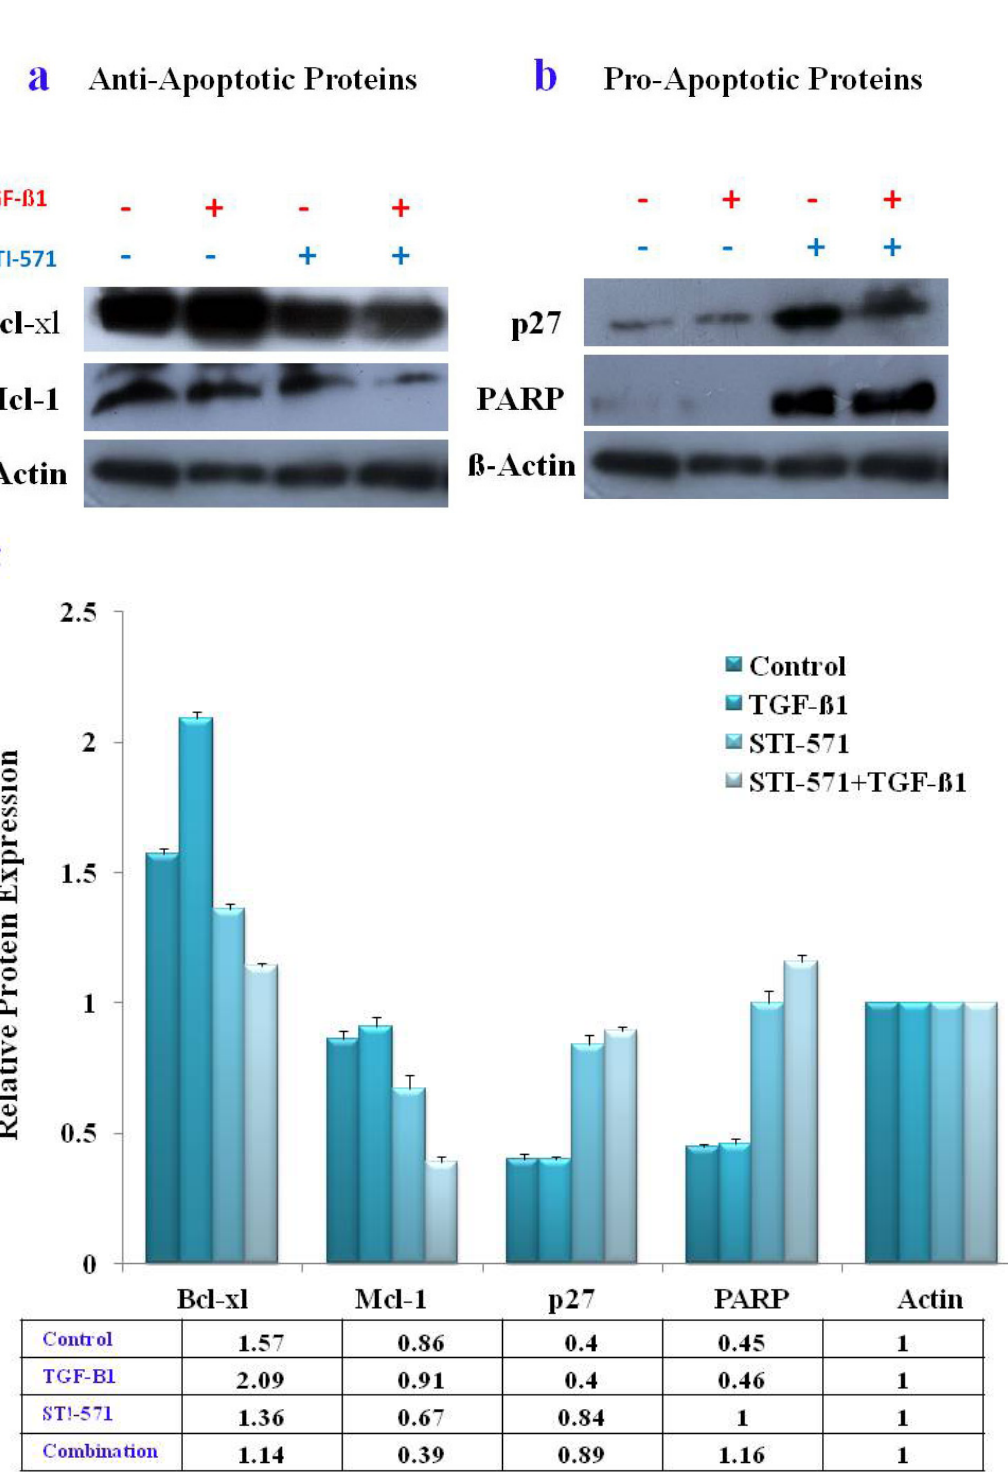
Figure 4: a,b) ) Protein expression of the anti-apoptotic proteins Mcl-1 and bcl-xL and the pro-apoptotic proteins p27 and cleaved PARP in K562 cells treated with 2 ng/mL of TGF-β1 and 0.5 µM STI-571, individually and in combination, for 48 h. The results for all groups were significantly different . c) Data is represented as mean± SD, and quantitative expression of proteins was normalized to the level of ß-actin. The results showed significant differences between treated groups and other groups (P <